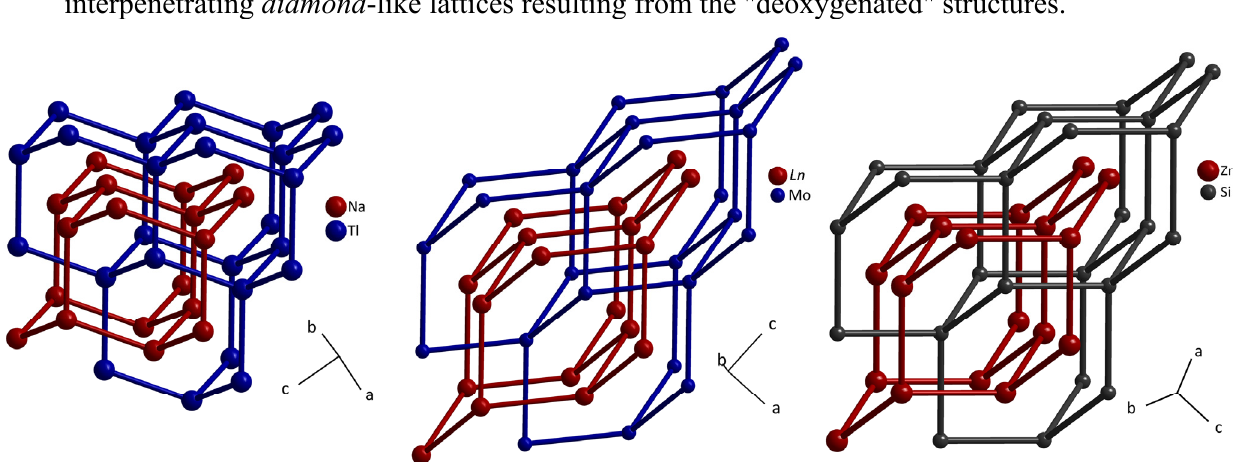
] ( right ) with special emphasis on the 4